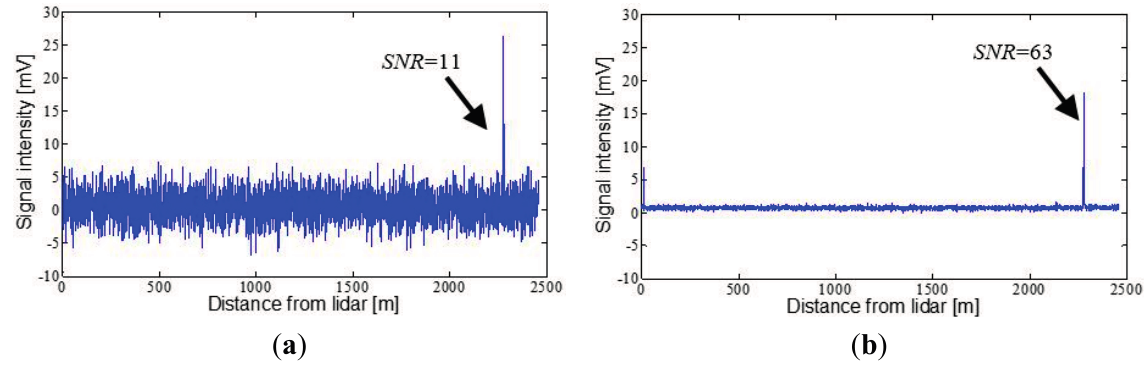
Figure 8. Range profile of lidar signal backscattered by several topographic targets. ( a ) Peaks corresponding to the crowns of a group of trees; ( b ) Detection of a building located at 1125 m from the lidar system.